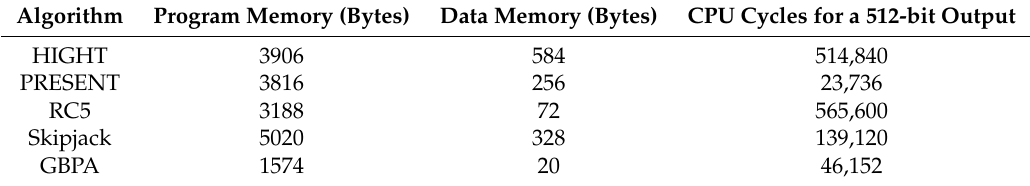
Table 9. Computing requirement comparison between lightweight block ciphers and GBPA.